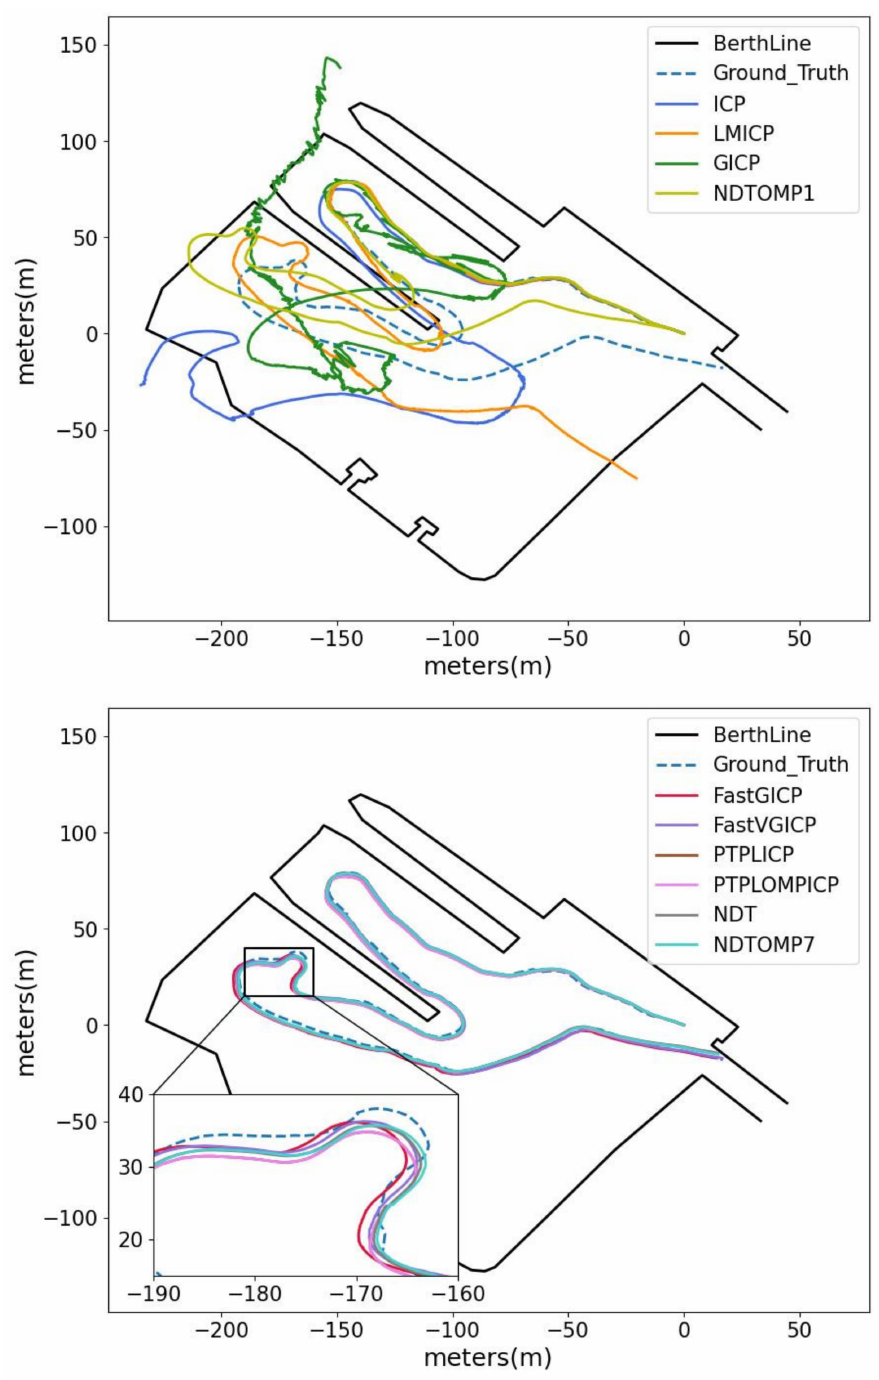
Figure 4. Comparison of output trajectories of registration